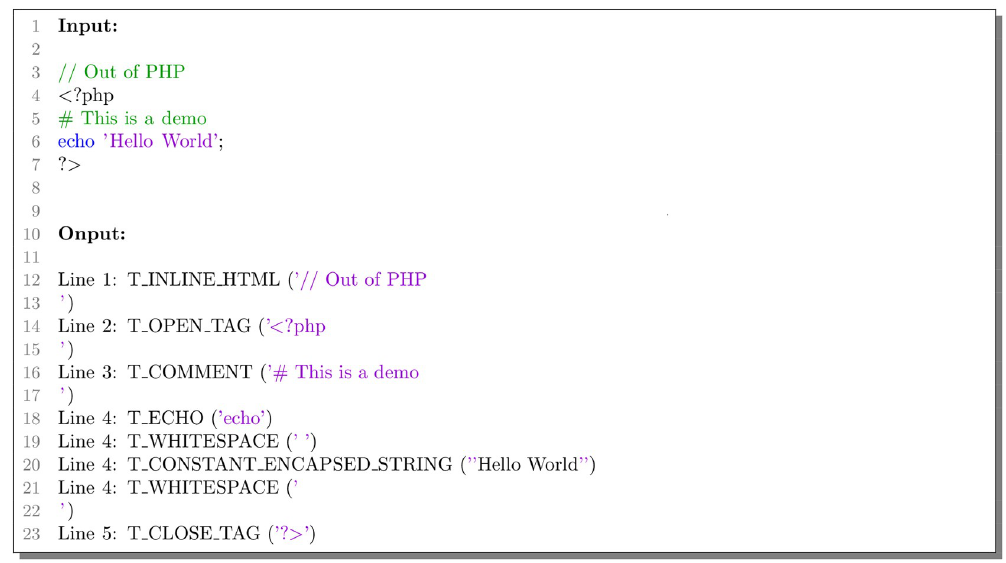
Fig 2. Example of PHP inbuilt